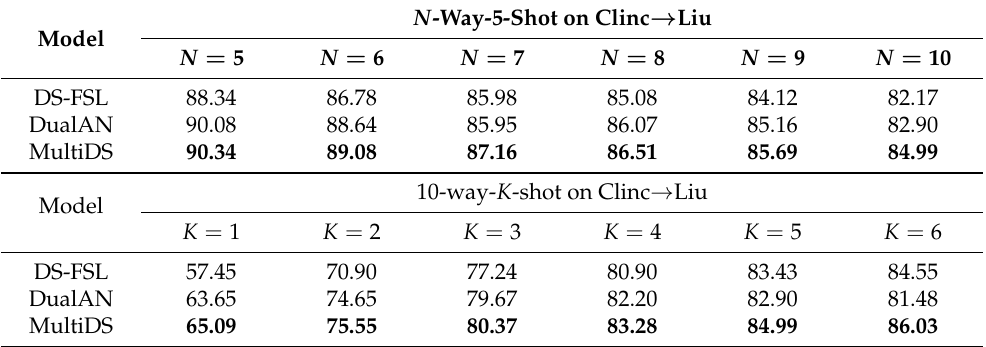
Table 7. Model stability verification on Clinc → Liu. The best results are emphasized using bold fonts.